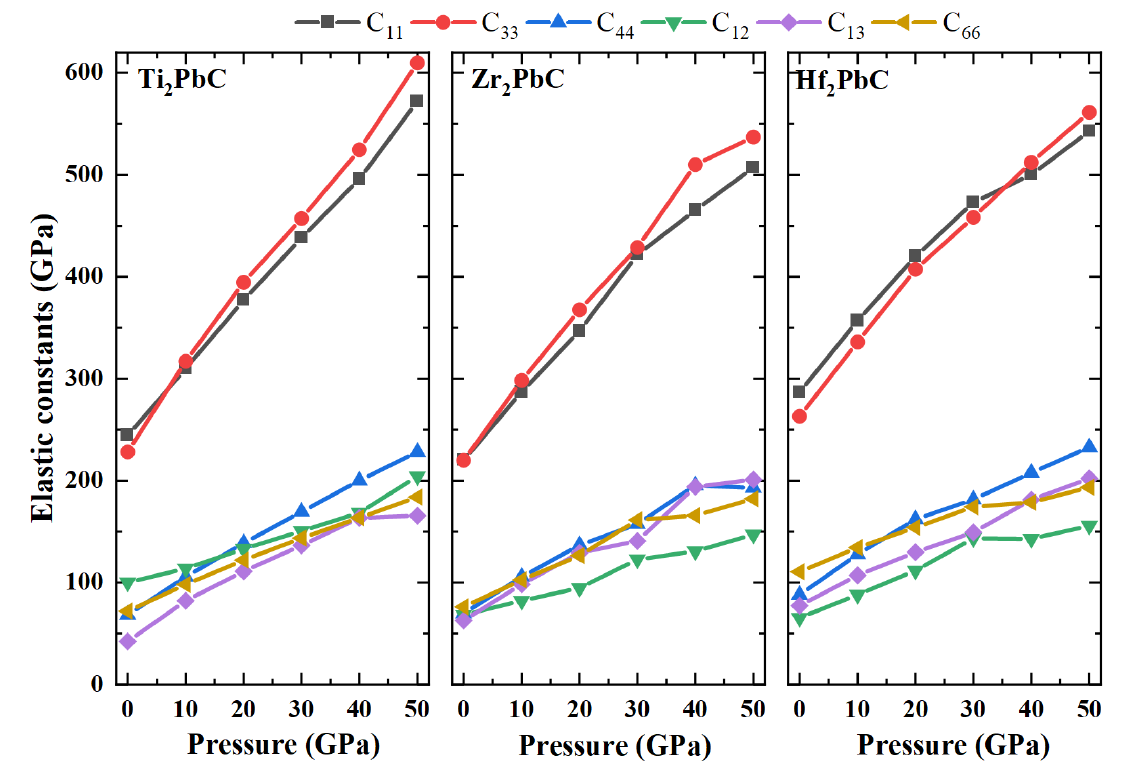
Figure 4. Elastic constants for M 2 GaC MAX phase (M = Zr, Hf) versus pressure.